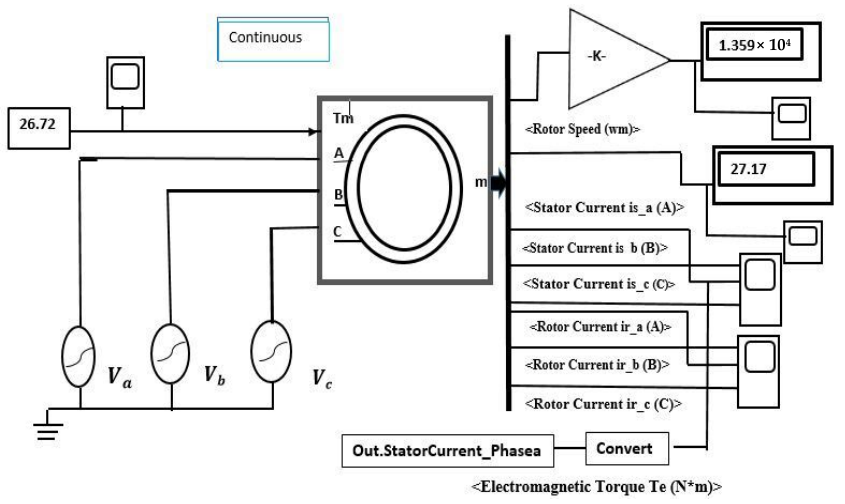
Figure 4. Healthy Motor SIMULINK model with A-C stator phases.